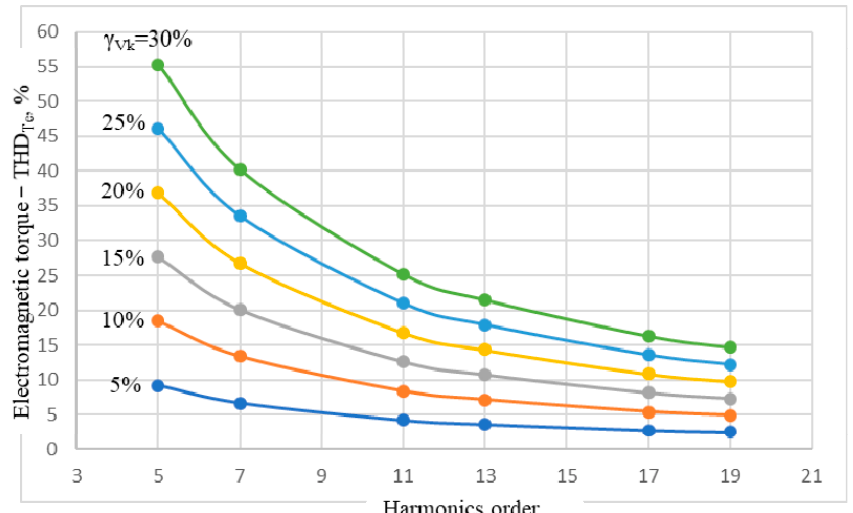
Figure 6. Total harmonic distortion factor of electromagnetic torque THD Te (k, γ Vk ).